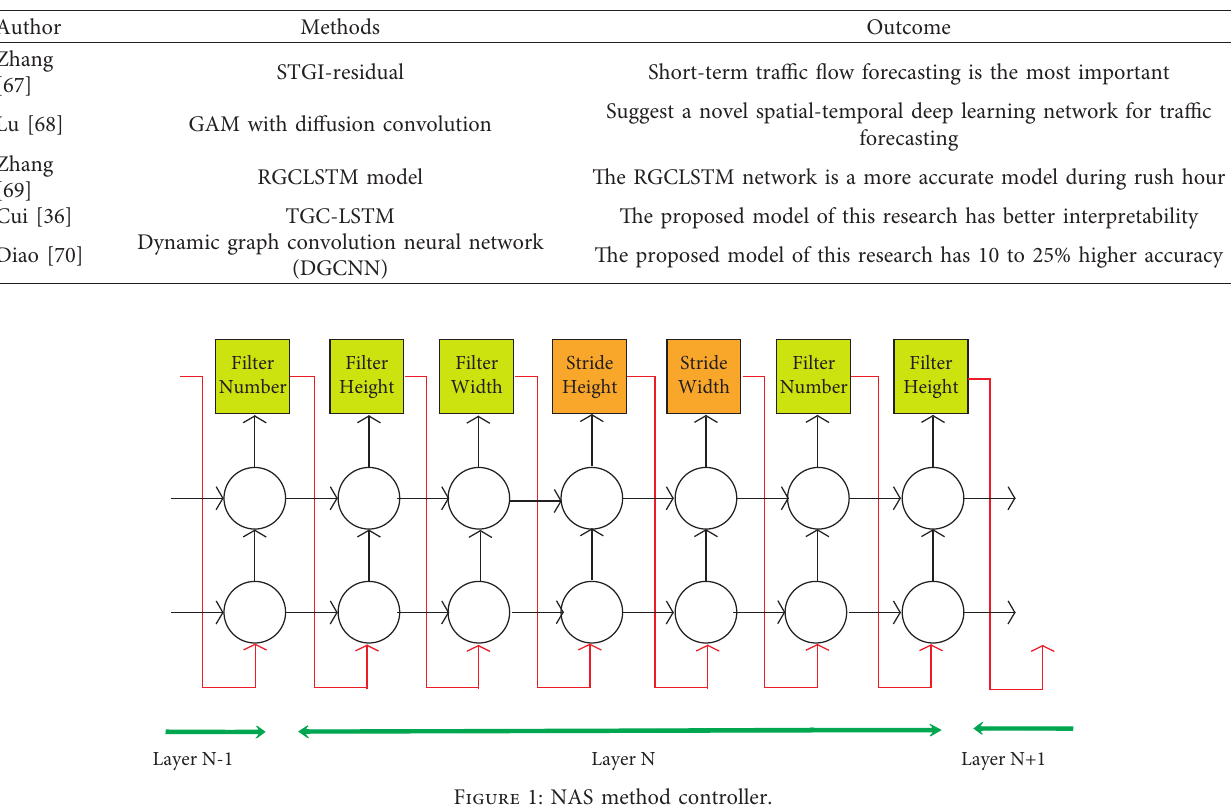
Table 2: Studies used deep learning for